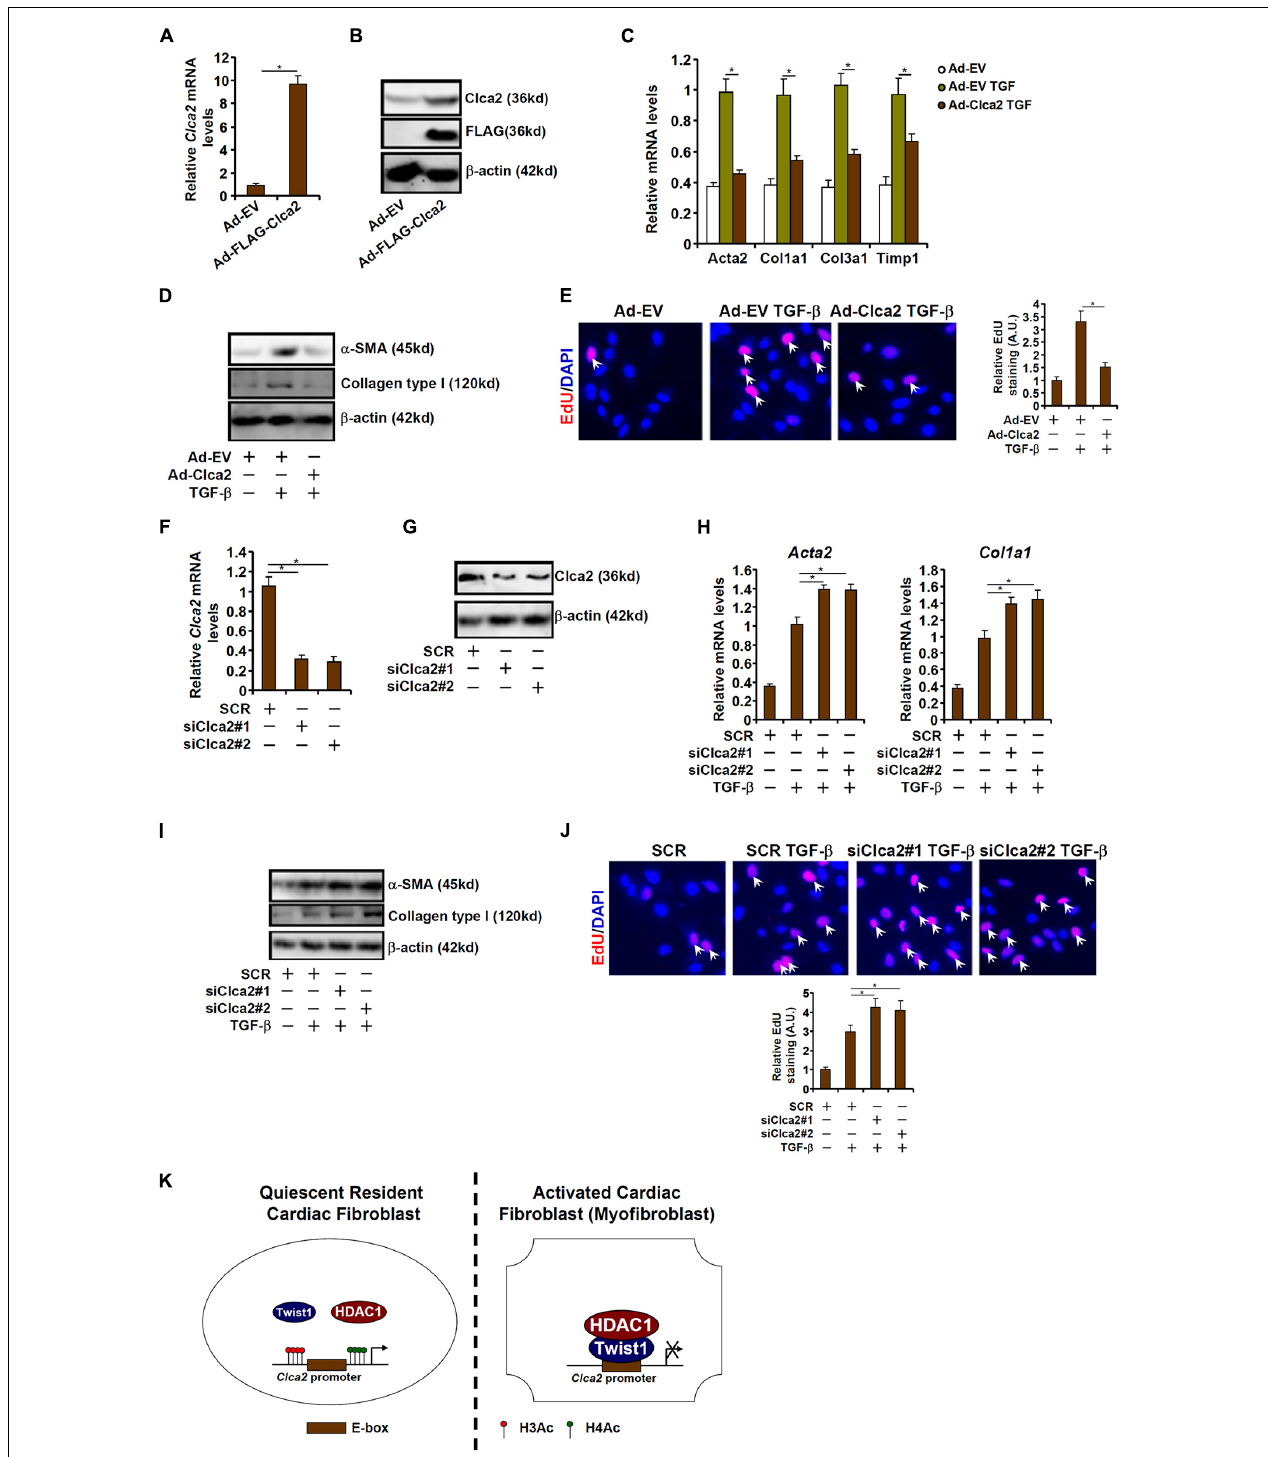
FIGURE 5 | Chloride channel accessory 2 (Clca2) regulates activation of cardiac fibroblasts. (A–E) Primary murine cardiac fibroblasts were infected with adenovirus carrying a Clca2 expression vector (Ad-FLAG-Clca2) or an empty vector (Ad-EV) followed by treatment with TGF- β . Expression levels of Clca2 were examined by qPCR (A) and Western (B) . Pro-fibrogenic genes were examined by qPCR (C) and Western (D) . Cell proliferation was examined by EdU incorporation (E) . (F–J) Primary murine cardiac fibroblasts were transfected with indicated siRNAs followed by treatment with TGF- β . Expression levels of Clca2 were examined by qPCR (F) and Western (G) . Pro-fibrogenic genes were examined by qPCR (H) and Western (I) . Cell proliferation was examined by EdU incorporation (J) . Error bars represent SD (* p < 0.05, two-way Student’s t -test). All experiments were repeated three times and one representative experiment is shown. (K) A schematic model.